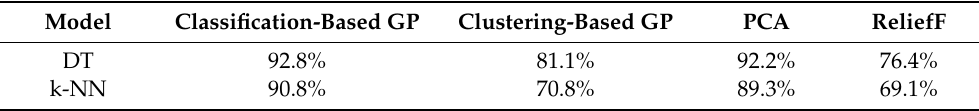
Figure 6. Constructed features through ( a ) clustering-based GP and ( b ) classification-based GP with an additional operating condition. Table 9. Classification accuracy (%) obtained with GP-based FCs, and feature extracted through PCA and ReliefF after adding a third machinery setting into the training